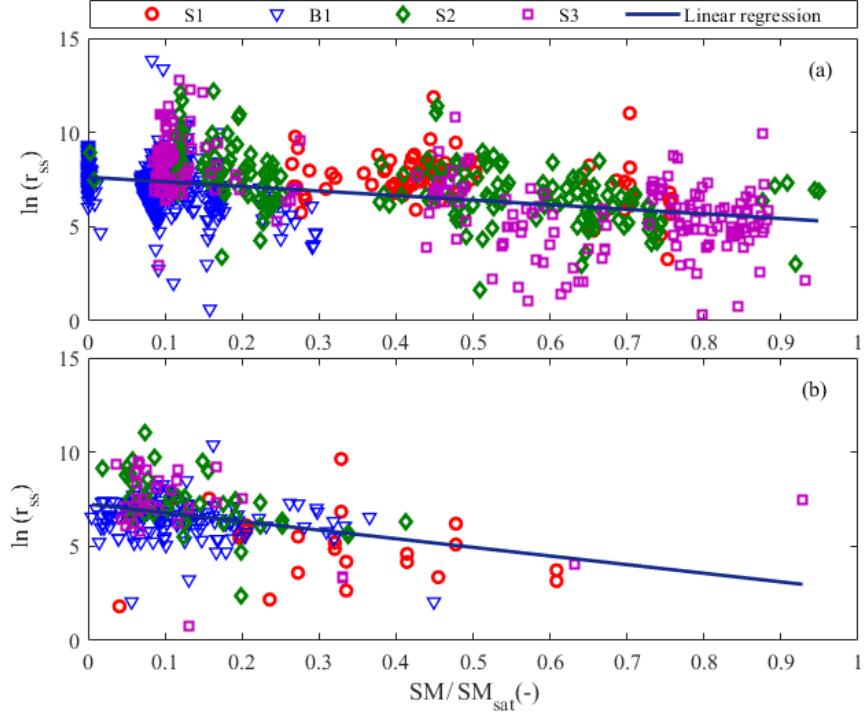
Figure 5. ln (r ss ) versus SM/SM sat (calibration step 1) using in situ (a) and satellite (b)